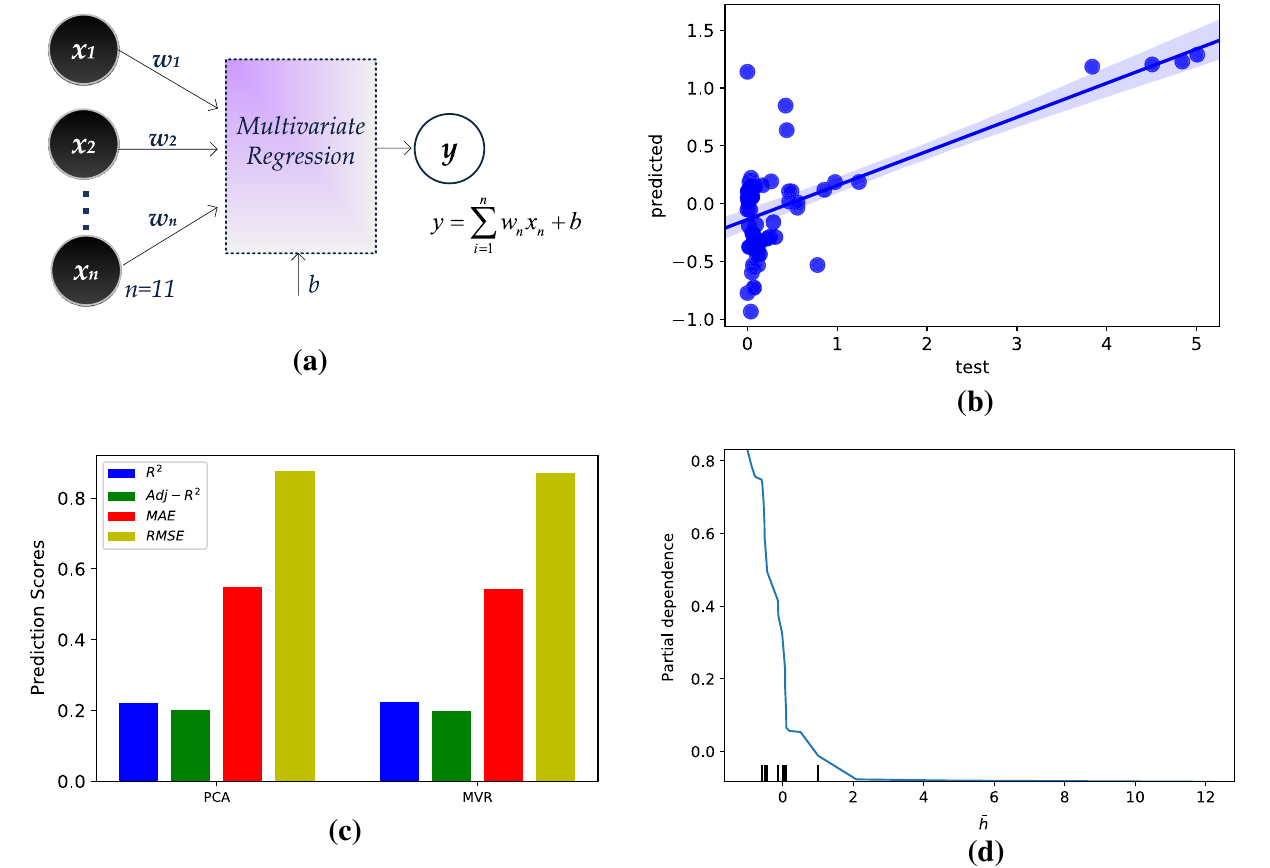
Figure 1. Model and results for the multivariate regression model (MVR), ( a ) data flow, ( b ) regression lines with 95% confidence level for the 9-input MVR model, ( c ) bar plot, quantifying R 2 , Adj-R 2 , MAE, and RMSE for the MVR model and the PCA model, and ( d ) partial dependence plot, revealing the dependence on the (normalized) channel height, h